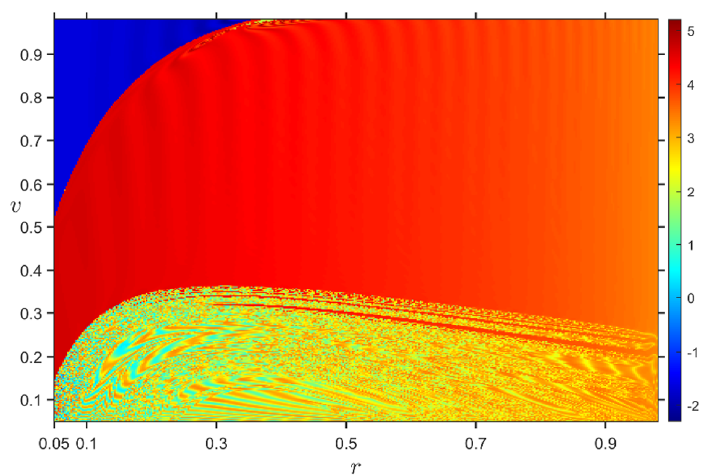
Figure 22 . Output of the small kink-antikink collisions process: final state of the scalar field φ (0 , t f ), with t f = x 0 /v + 100 as a function of r and initial velocity v .